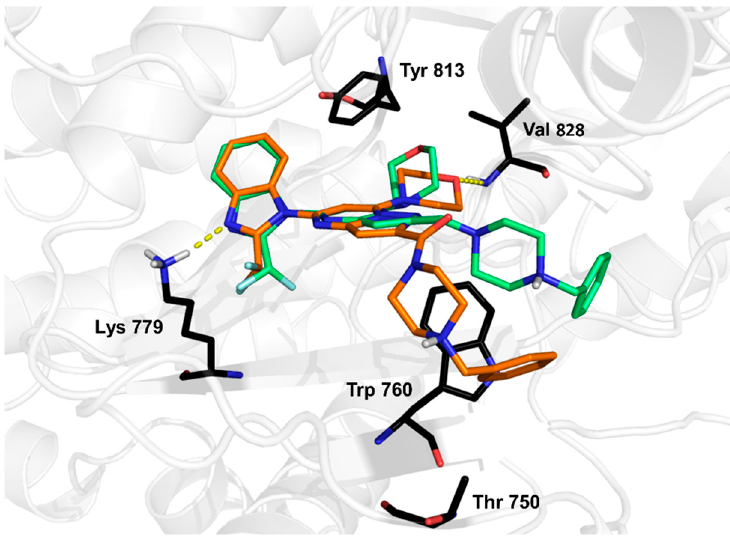
Figure 3. Illustration of the binding modes of compounds 6 (green) and 10 (orange) in the catalytic center of PI3K δ obtained by molecular docking. Table 2. Influence of the fluorine atom(s) on PI3K δ inhibition and the respective docking scores for each compound.